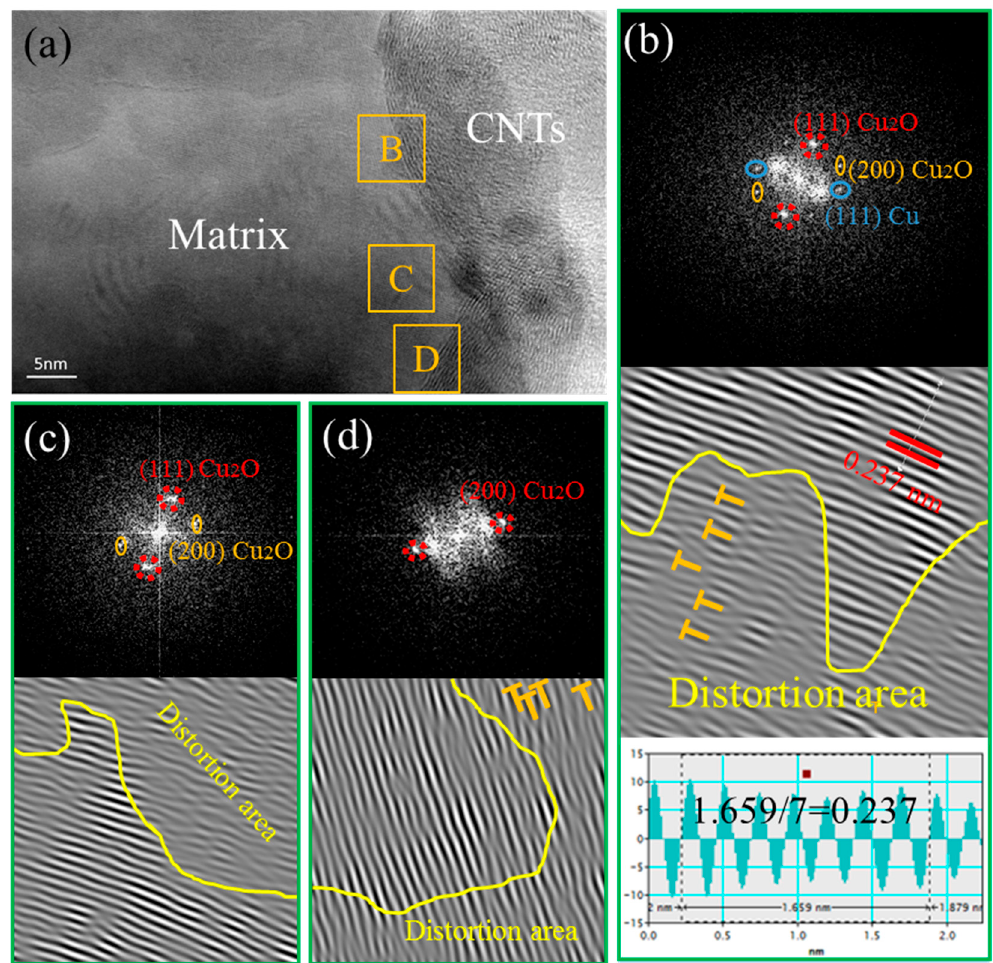
Figure 8. ( a ) TEM image of 0.3 wt % CNT-Cu composite; ( b ), ( c ), ( d ) fast Fournier transform (FFT) (upper) and inverse fast Fournier transform (IFFT) (under) of regions B, C, and D,